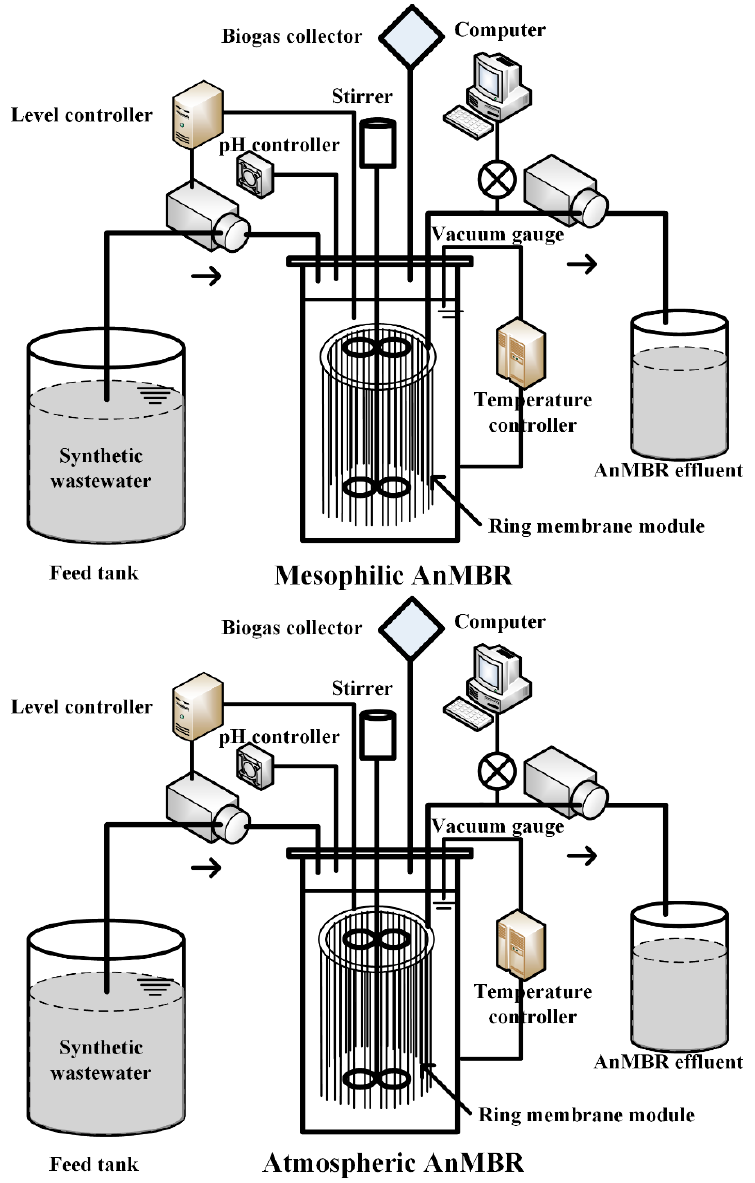
Figure 1. Schematic of the mesophilic and atmospheric anaerobic membrane bioreactor and experimental setup.